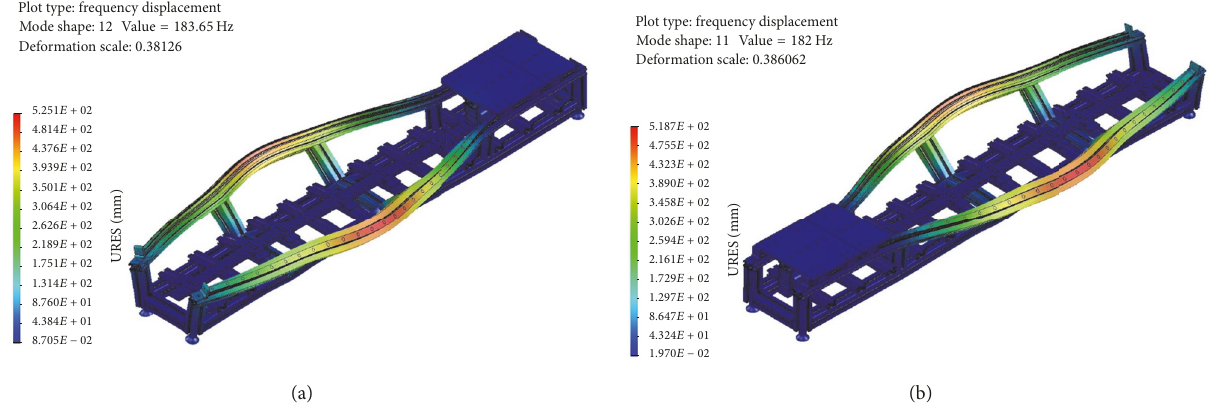
Figure 13: First-order mode shapes (mode 11), transversal displacement on top lateral bars in phase opposition: (a) position P1 ( 𝑓 ≈ 184Hz, def. scale = 0.381); (b) position P5 ( 𝑓 ≈ 182Hz, def. scale ≈ 0.386).